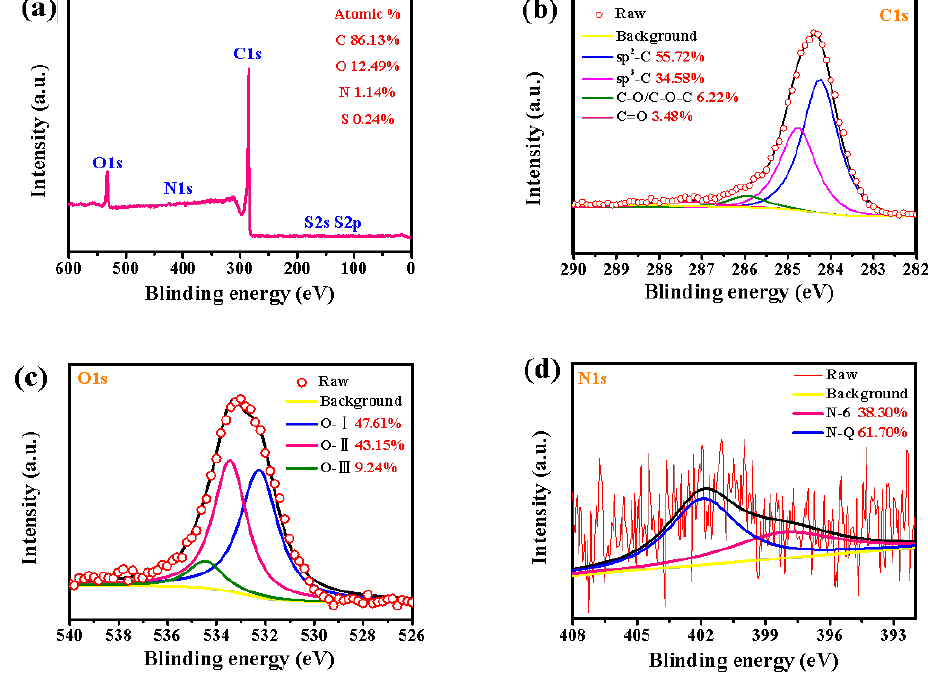
Figure 3. XPS spectra of of LSPC800: ( a ) full spectrum, ( b ) C1s, ( c ) O1s, and ( d ) N1s. Table 1. Element content (atomic %) of the longan shell 3-dimensional porous carbons (LSPCs) by XPS.